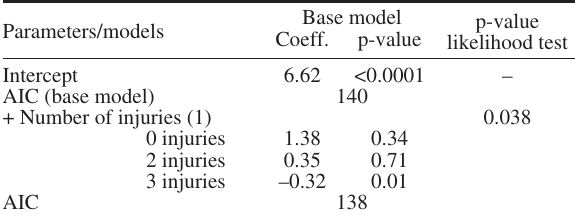
Table 6. – Results of Weibull model for survival of Conger con- ger , without covariates (base model) and model including number of injuries as possible explanatory variable for observed mortality. Significance level α